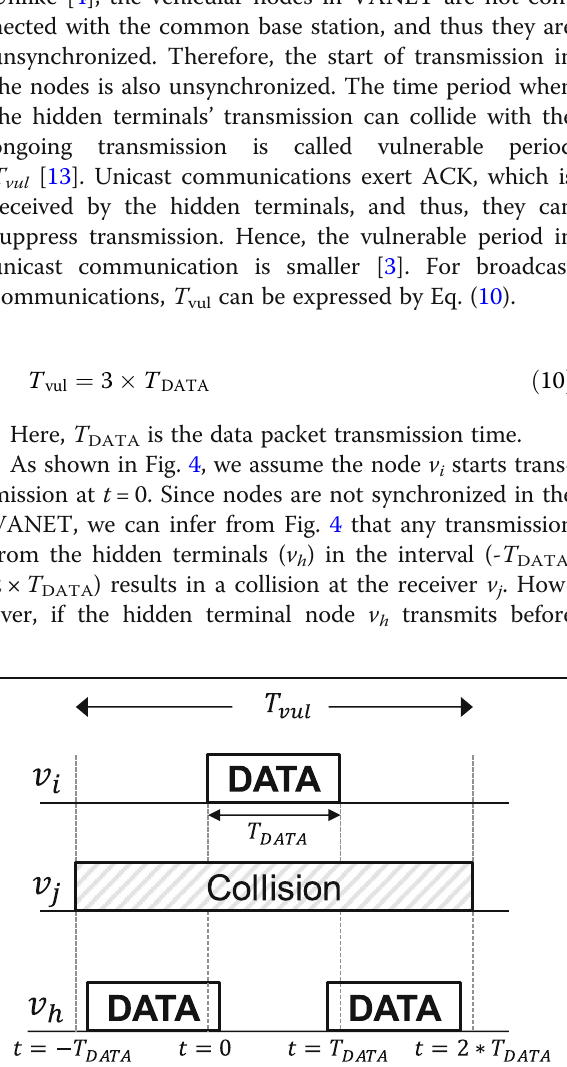
Fig. 4 Time frame analysis of hidden terminal collision at the receiver node to calculate the vulnerable